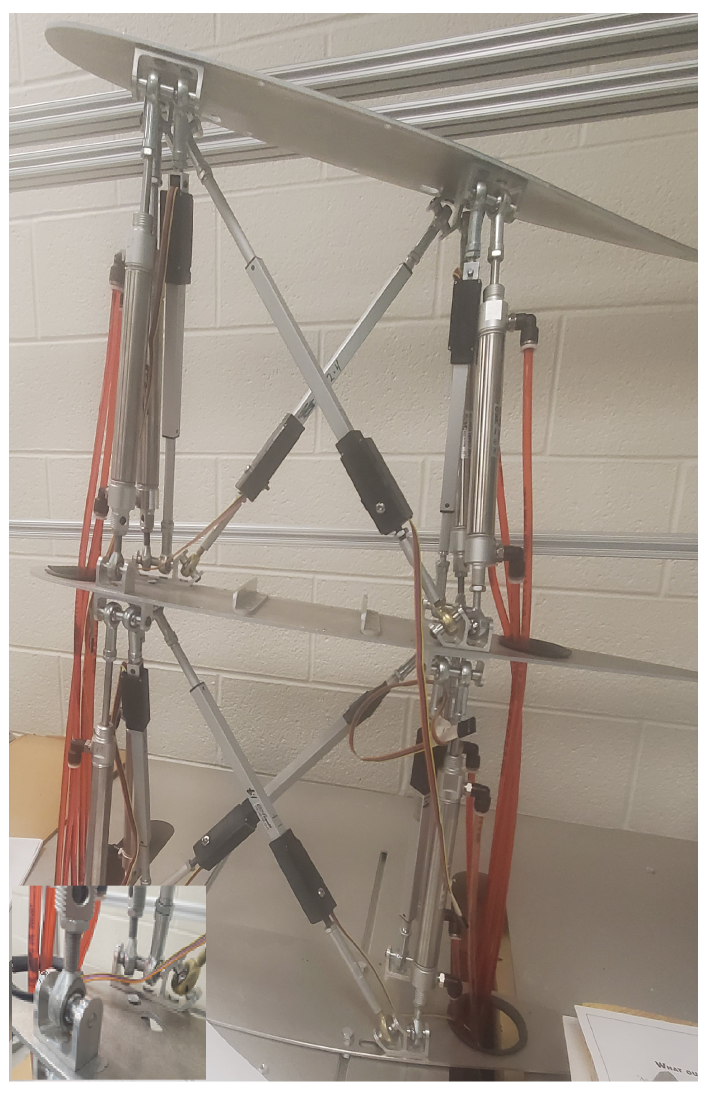
Figure 1. Re–configurable modular morphing wing with spherical joint in